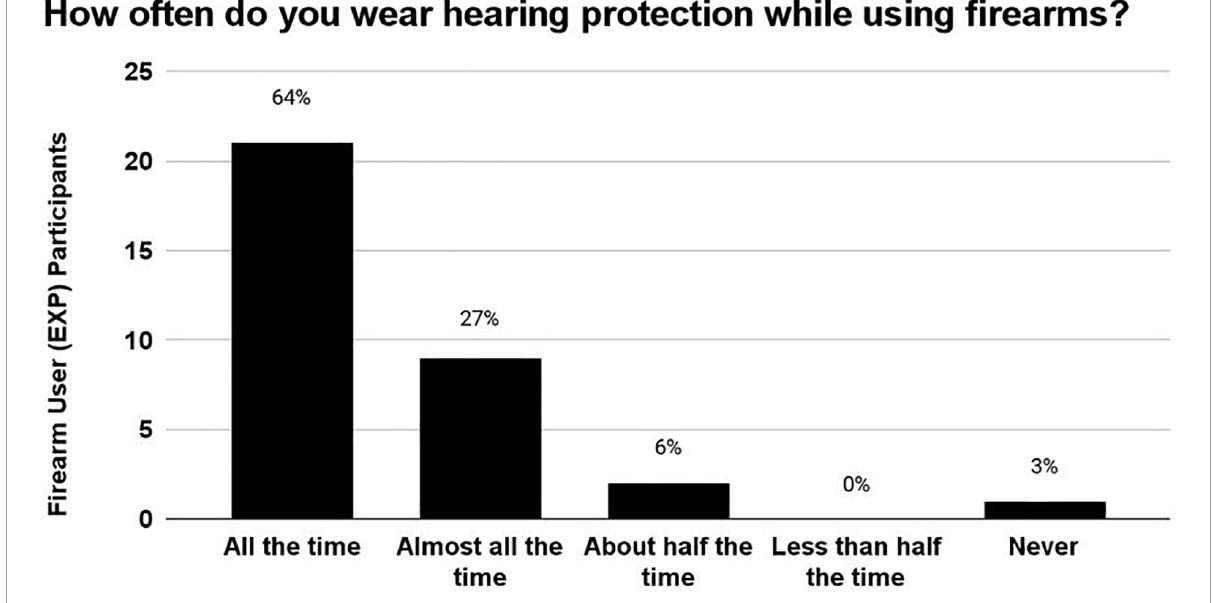
FIGURE4 The number of occasions on which the EXP participants reportedly used firearms ranged from 5 to 200 occasions. During these occasions of firearm use, 91% of EXP participants reportedly wore hearing protection either “All of the time” or “Almost all the time”, indicating that this cohort used HPDs